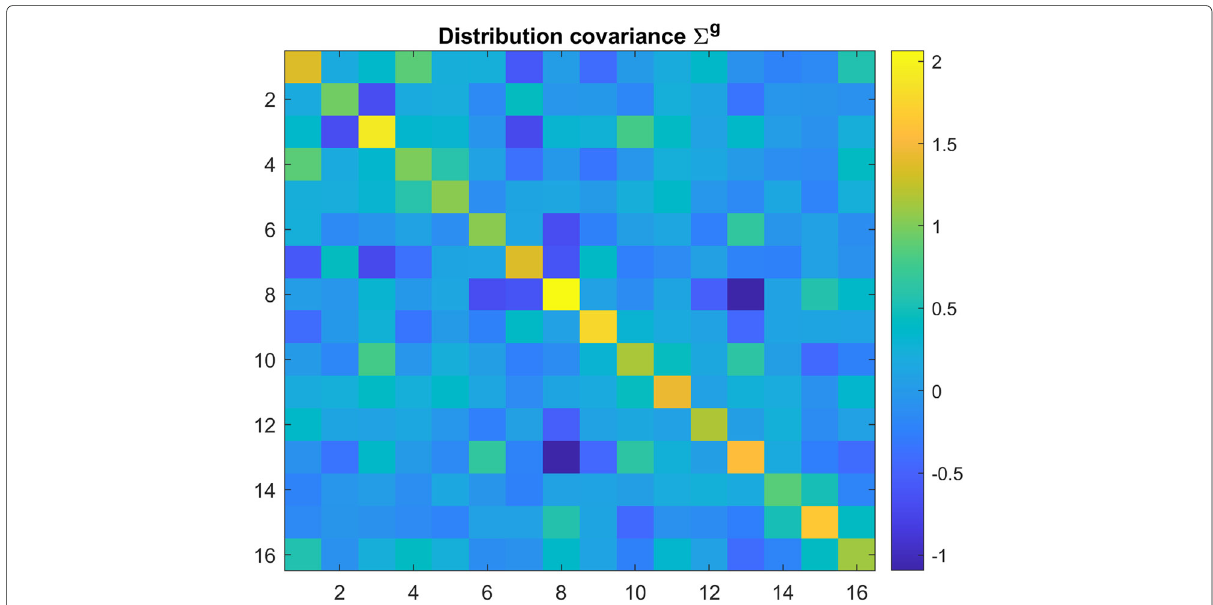
Fig. 8 Generated Distribution Covariance: Covariance matrix of the principle vector w used to synthesize more general data